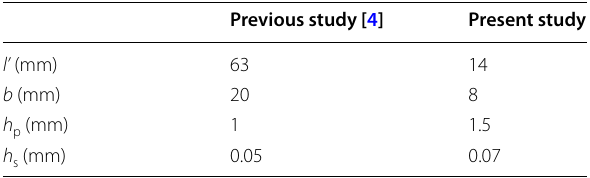
Table 1 Specifications of force sensor in previous and present